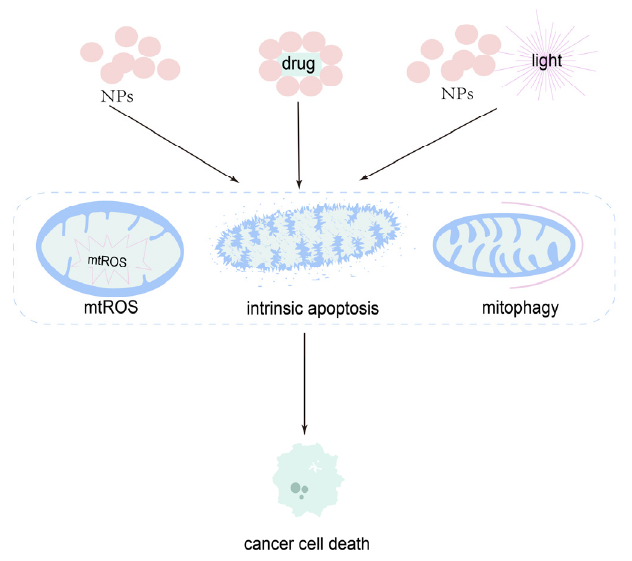
Figure 8. Mechanism of NPs targeting mitochondria as a therapy for OSCC. NPs alone, NPs loaded with drugs, and NPs plus light can induce cancer cell death via mtROS, the mitochondrial apoptosis pathway, and mitophagy.